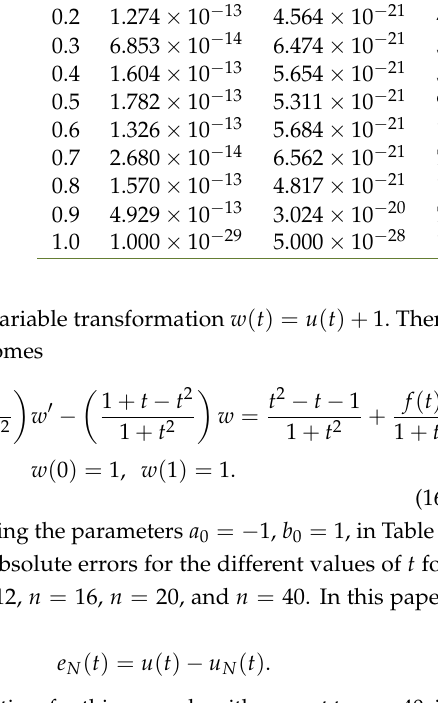
Table 1. The absolute errors | e N ( t ) | for Example 1, for various values of n .